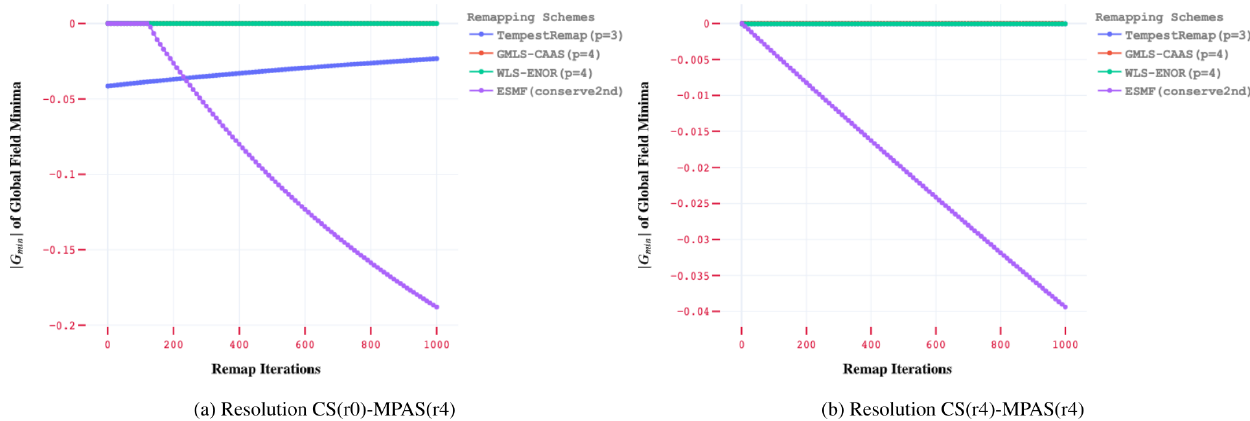
Figure 9. | G min | metric for the TOPO field on CS-MPAS with different source mesh